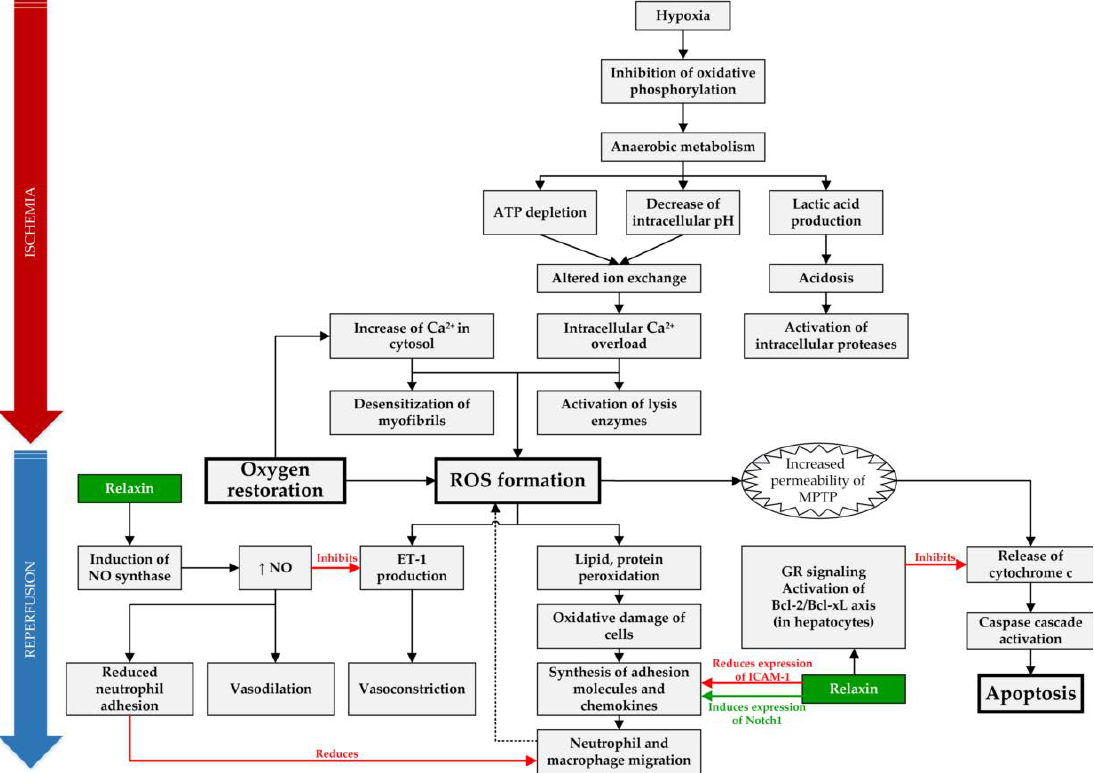
Figure 1. Overview of targets of RLX in IRI. In IRI setting, RLX has anti-inflammatory effect by reducing expression of intracellular adhesion molecule 1 (ICAM-1), inducing expression of Notch1 in macrophages and by reducing neutrophil adhesion through increased synthesis of nitric oxide (NO) [30,36]. Furthermore, it acts as an anti-apoptotic agent in hepatocytes by binding to the glucocorticoid receptors (GR) and inhibiting release of cytochrome c from mitochondria [31]. Lastly, RLX causes vasodilation through increased NO production, which acts as a vasodilator and reduces vasoconstriction by inhibiting endothelin 1 (ET-1) production [38]. (ROS—reactive oxygen species, MPTP—mitochondrial permeability transition pore).